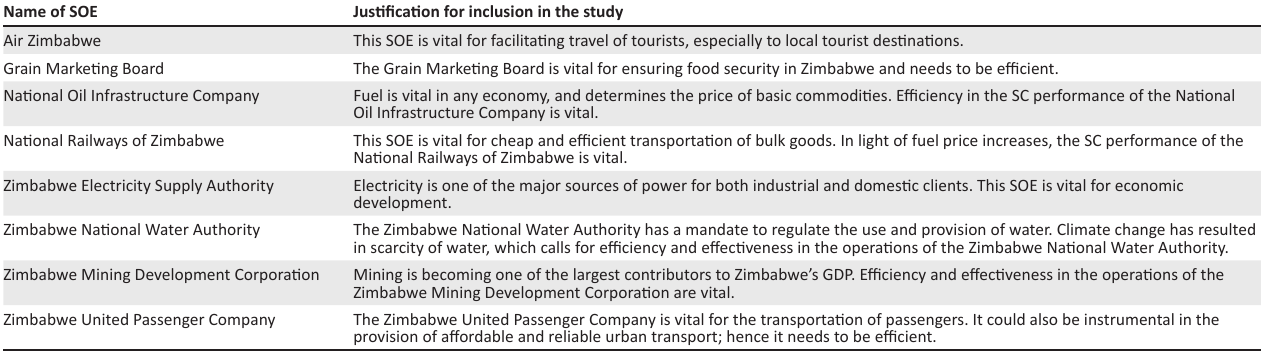
TABLE 1: Zimbabwean state-owned enterprises studied and justification for inclusion. Name of SOE Justification for inclusion in the study Air Zimbabwe This SOE is vital for facilitating travel of tourists, especially to local tourist destinations. Grain Marketing Board National Oil Infrastructure